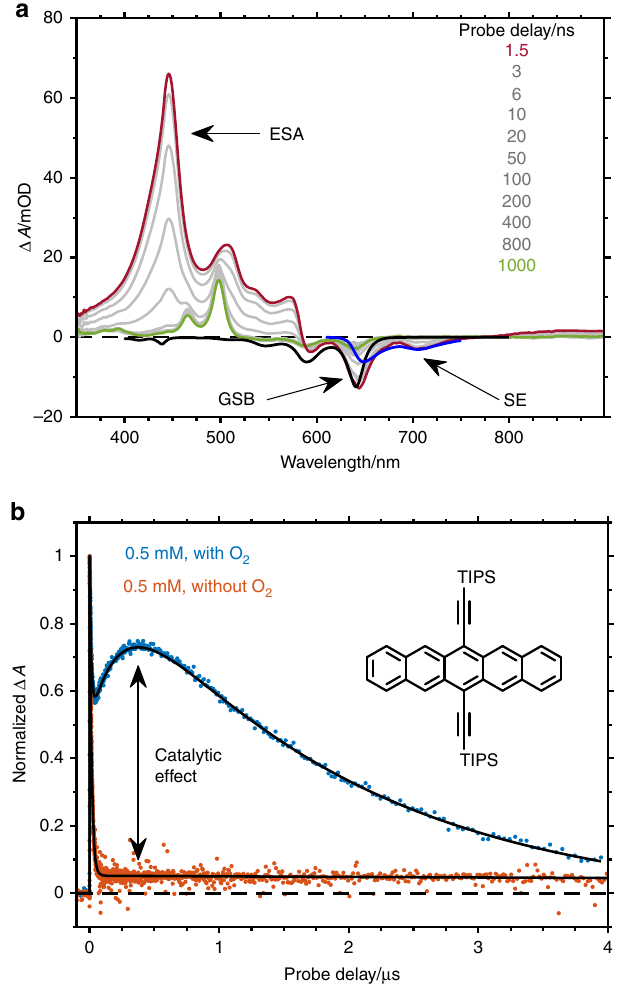
Fig. 3 Spectral evolution in time and oxygen dependence of kinetic traces. a Spectral evolution of a 0.5 mM solution of TIPS-Pn in THF. In the initial 6 ns, the transient spectrum is determined by S 1 excited-state absorption with a maximum at 450 nm. Additionally, signatures of ground-state bleach and stimulated emission are observed at 640 and 700 nm, respectively, in good agreement with the absorption and emission spectra (black and blue lines). After 50 ns, a triplet ESA with a maximum at 500 nm can be observed in lieu of the singlet. No further spectral changes are observed. b Selected transients at 500 nm probe wavelength. The kinetic traces for a 0.5 mM solution of TIPS-Pn (see inset) show a stark contrast when using THF stored under atmospheric conditions (blue) compared to degassed THF (red). At the maximum of the triplet ESA (500 nm), the initial fast decay of the singlet is observed. In the case of degassed THF, the amplitude of the triplet is very weak at µ s delays. However, in the solution containing oxygen, after the fast singlet decay, the triplet amplitude rises slowly until a local maximum is observed at a probe delay of ≈ 0.4 µ s. This behaviour indicates an oxygen-catalysed SF process. Additionally, the triplet decays ¼ 28 : 2 μ s ; τ ¼ 1 : 8 μ s ) much faster than in the degassed solution ( τ O 2 deg due to further interaction with oxygen (see Supplementary Note 5 for more details). Source Data are provided as a Source Data fi